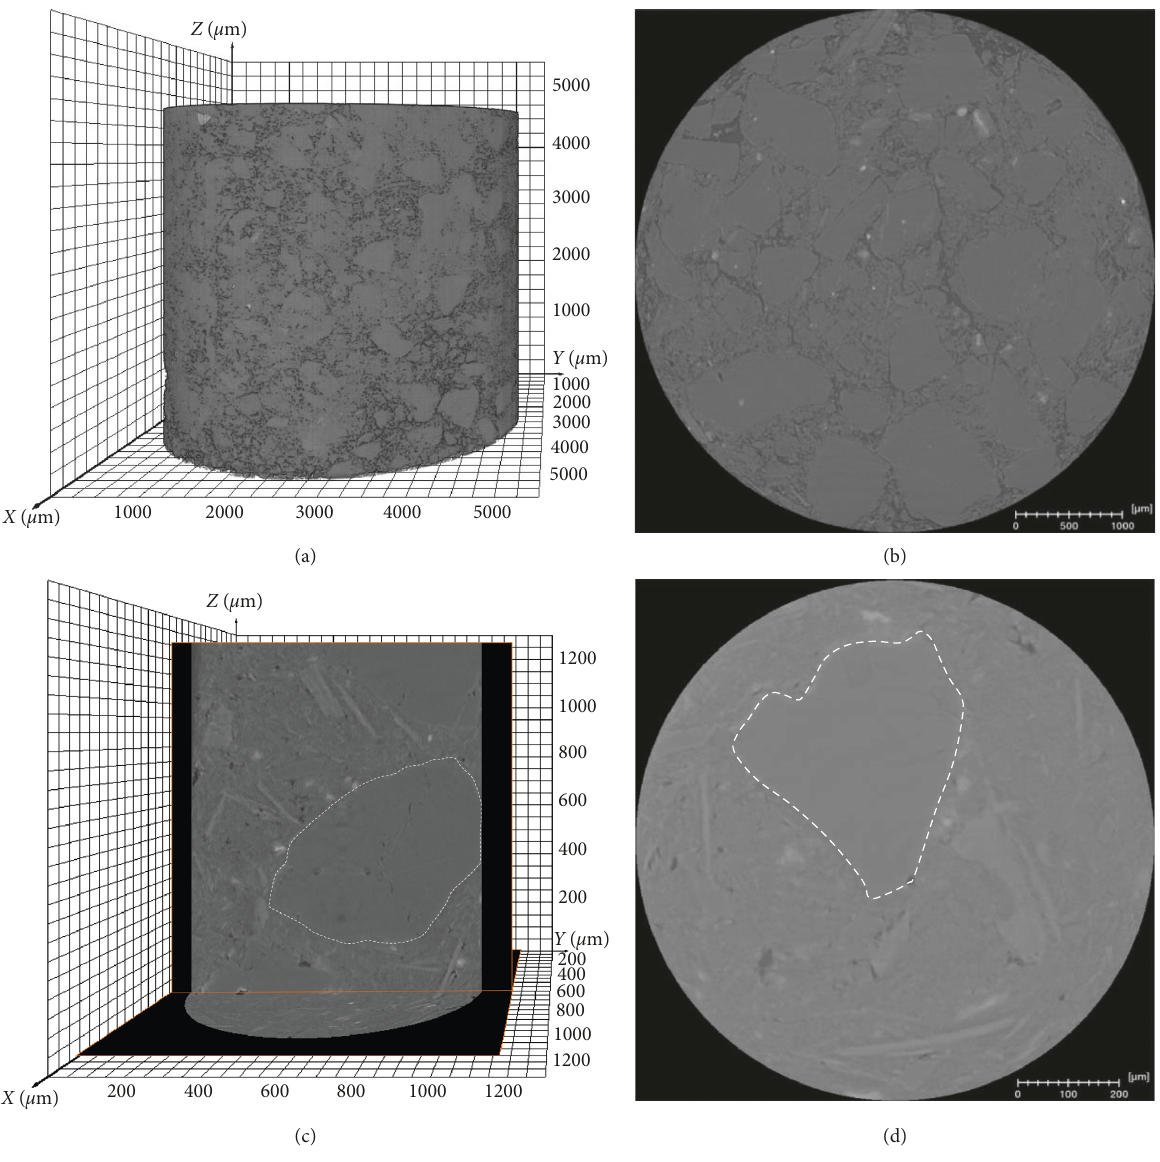
Figure 9: Aggregates-dominated structure of the compacted Guangzhou clay scanned with two different objective lens. (a) 3D re- construction with the 2X objective lens (3.25 m/pixel). (b) Slice image with the 2X objective lens. (c) 3D reconstruction with the 10X objective lens (0.65 m/pixel). (d) Slice image with the 10X objective